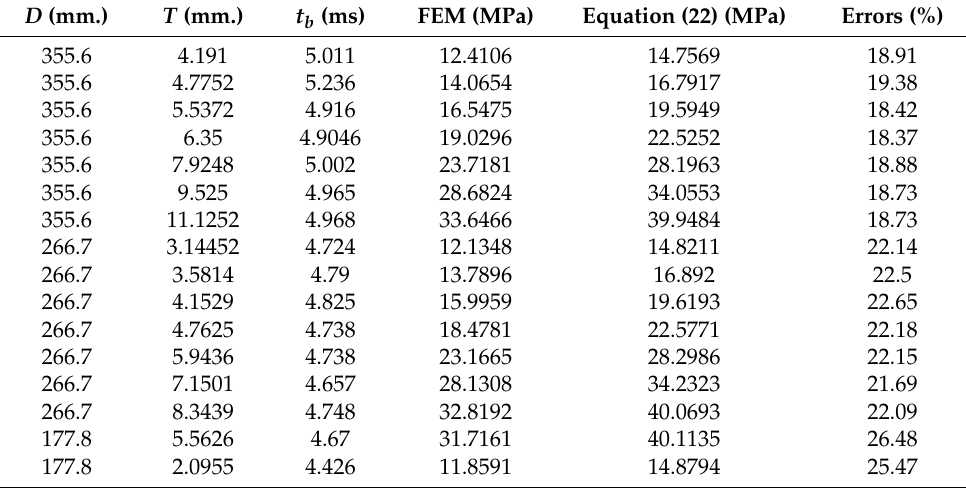
Table A1. Comparisons between the FEM results and the predictions, when t d = 3.9 ms. D